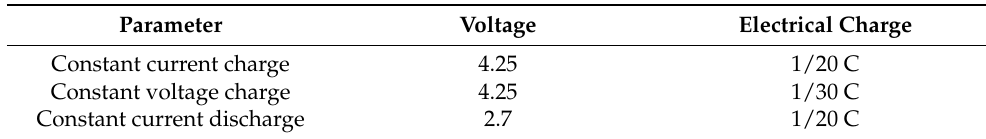
Table 3. Parameters used in the measurements of the charge–discharge performances of the fabricated Li-NMC-811 batteries with a variation of cathode material precursors using Battery System Test 8 (BST 8), Neware 3000.